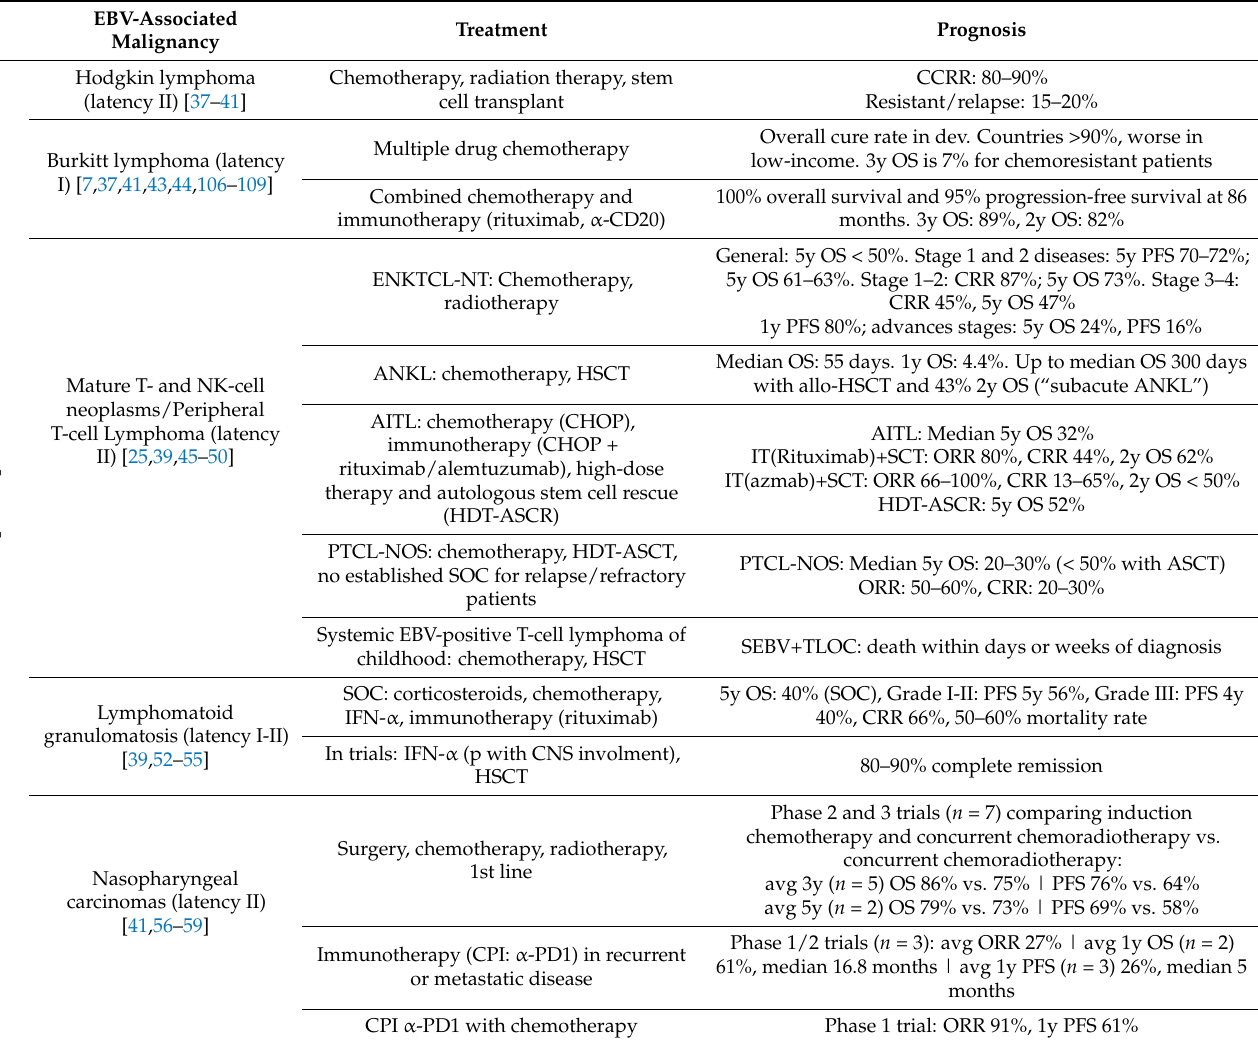
Table 2 complements this summary by providing an overview of the current standard of care (SOC) for these diseases. Currently in surgery, solid organ transplants (SOT), antivi- ral therapeutics (highly active antiretroviral therapy (HAART), combined antiretroviral therapy (cART), chemotherapy (etoposide, prednisolone, oncovin, cyclophosphamide and hydroxydaunorubicin (EPOCH); cyclophosphamide, hydroxydaunorubicin, oncovin, pred- nisone (CHOP)) and radiation therapy regimens and a combination of these are the most common approaches. At present, more promising treatments through immunotherapy are gaining traction, i.e., adoptive T cell therapy (ACT), checkpoint inhibiting (CPI) monoclonal antibodies (mAbs) and hematopoietic/autologous stem cell transplants (H/A-SCT)—also in combination with traditional methods. Among many others (cancers, as seen in both tables), one of these newer immunotherapeutical treatments has been examined for mul- tiple sclerosis. Despite lacking a clear causality between EBV and MS, a recent study on EBV-specific T cell therapy in patients with progressive multiple sclerosis resulted in significant clinical improvement and thus could open the door for a wider adoption of alternative therapeutical approaches for MS [105]. Table 2. Current standard of care (SOC) including prognosis for EBV-associated diseases. For abbreviations, see Table 1. EBV-Associated Treatment Malignancy